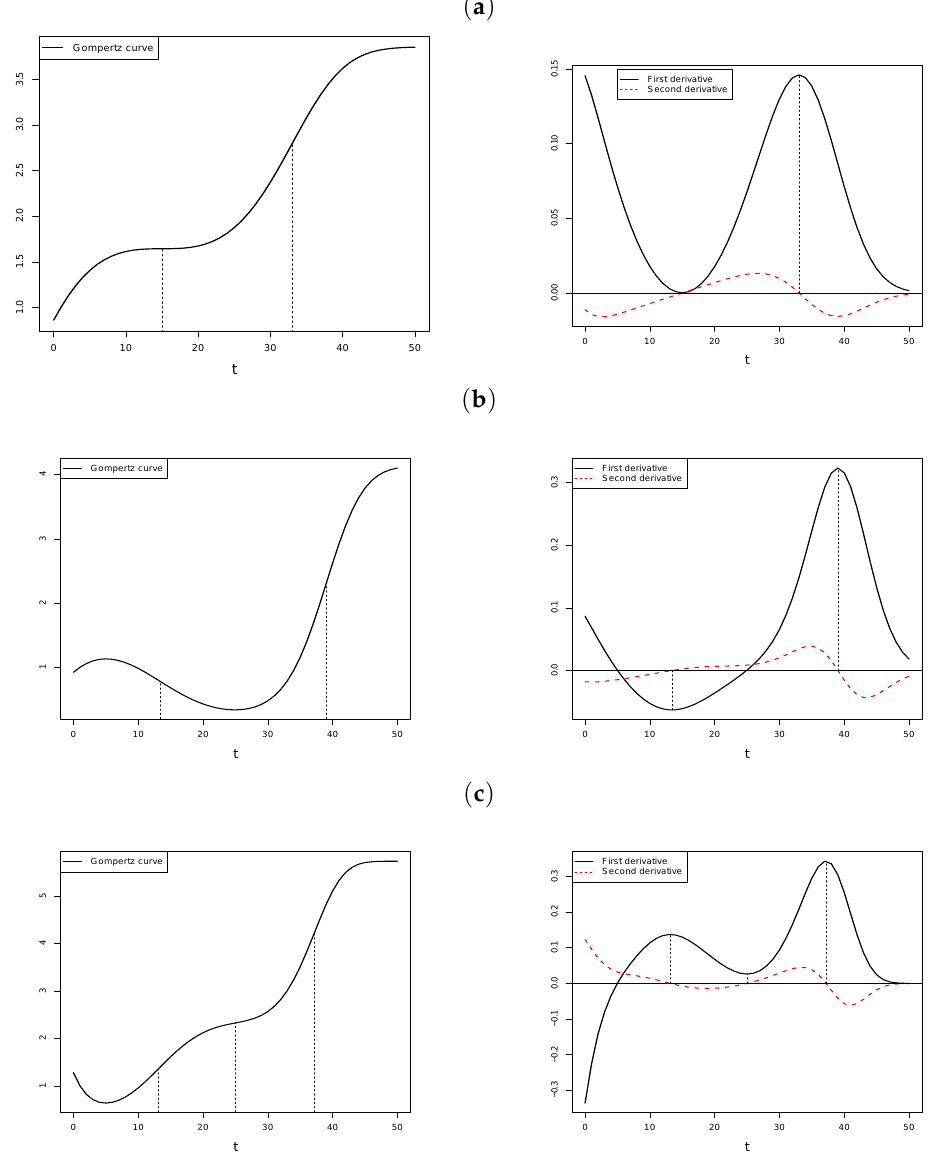
Figure 1. Strictly increasing Gompertz curve with two inflection points ( a ). Decreasing and increasing curves with two ( b ) and three ( c ) inflection